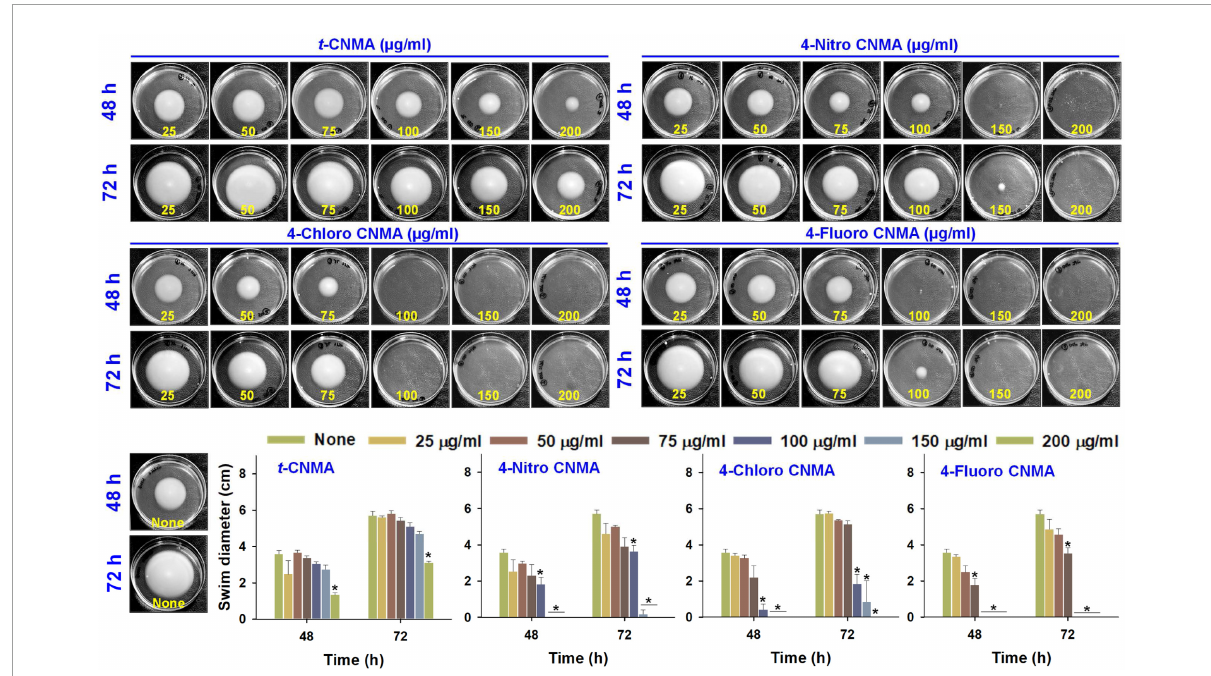
FIGURE5 Swimming motility of A. tumefaciens on motility agar (1% peptone, 0.25% agarose, and 0.5% NaCl) and its inhibition by t -CNMA, 4-nitro CNMA, 4-chloro CNMA, and 4-fluoro CNMA (25–200 µ g/ml) after exposure for 48 and 72 h. “*” denotes a significant difference in swim diameter by the two-tailed t -test ( P ≤